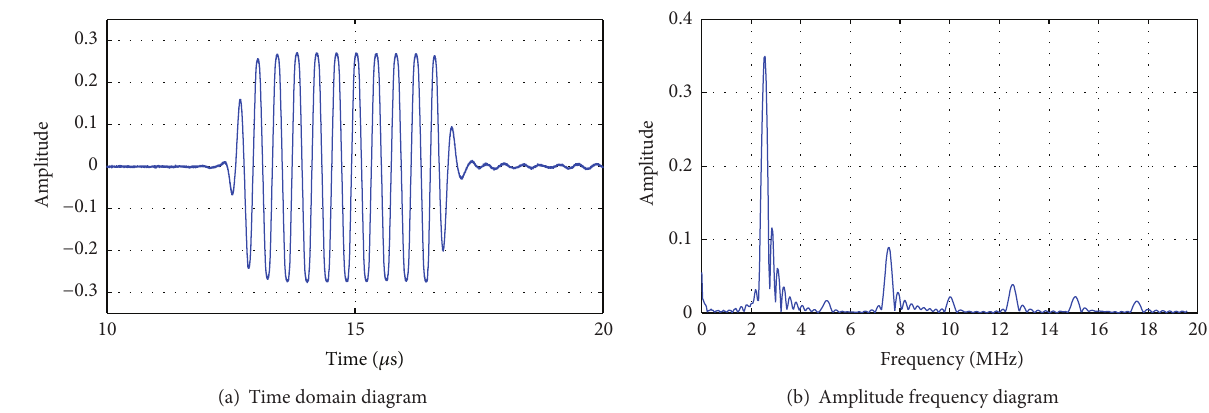
Figure 6: Time domain and amplitude frequency diagrams of received